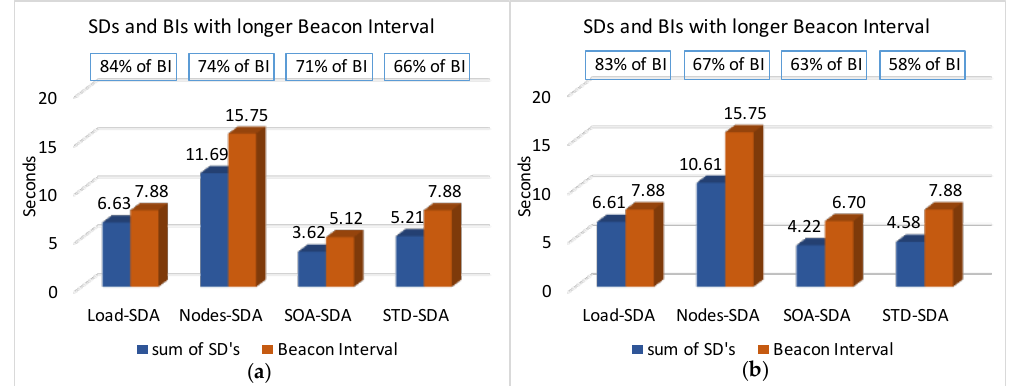
Figure 21. Average sum of superframe durations and beacon interval for the allocation schemes with adjustment of BI: ( a ) Unconditioned Scenario; ( b ) Conditioned